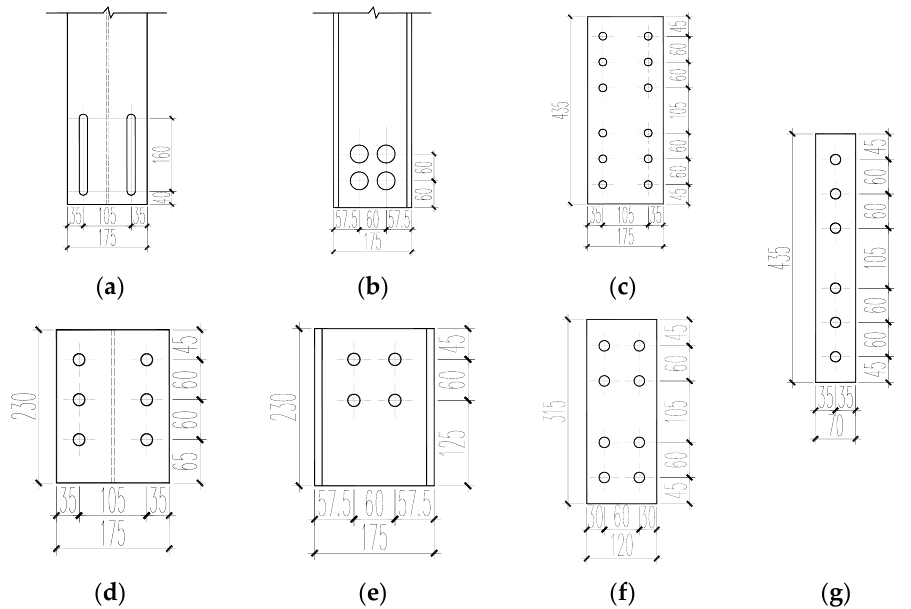
Figure 6. Details of specimens: ( a ) flange of upper steel column; ( b ) web of upper steel column; ( c ) cover plates of external flange; ( d ) flange of lower steel column; ( e ) web of lower steel column; ( f ) cover plates of web; ( g ) cover plates of inner flange. Table 1. Material properties of